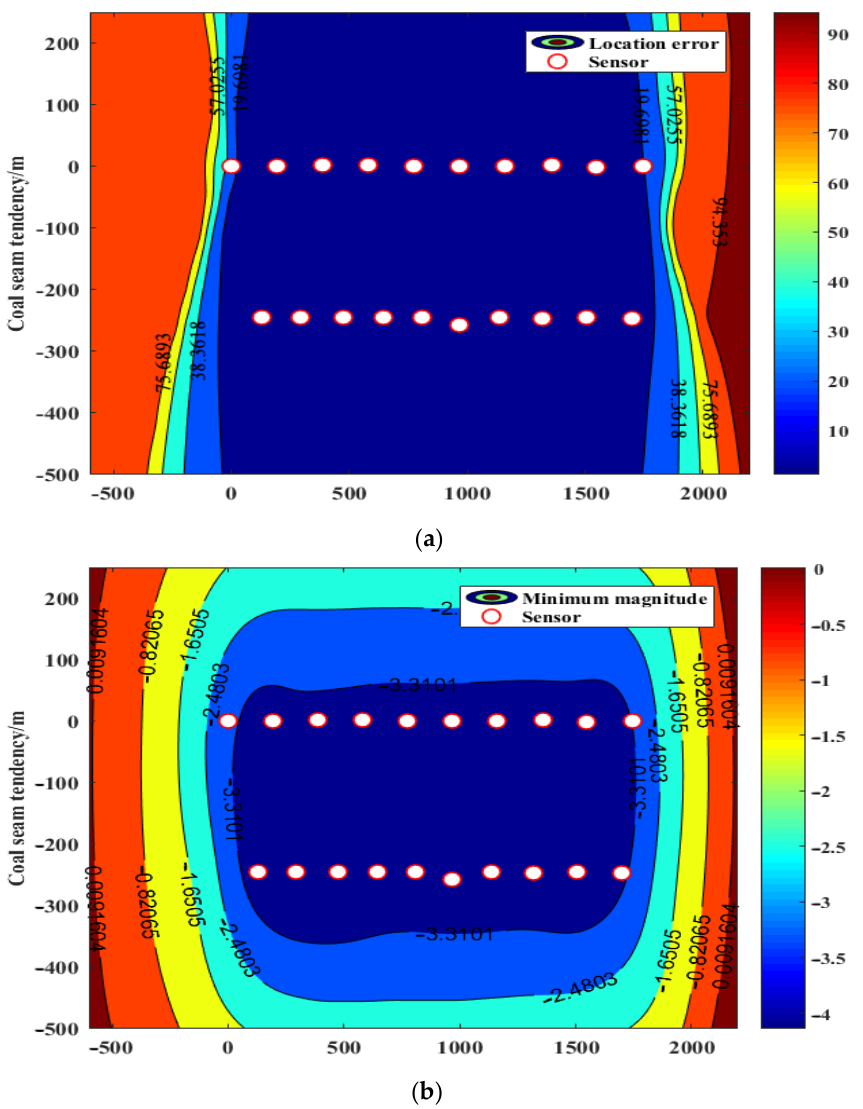
Figure 12. Evaluation of sensor arrangement on the coal seam roof (970 m). ( a ) Positioning errors. ( b ) Sensitivity.